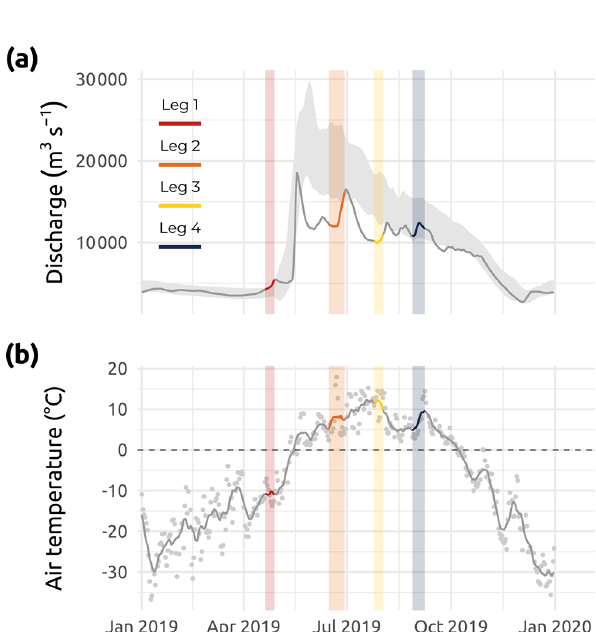
Figure 3. (a) Mackenzie River discharge (m 3 s − 1 ) from Jan- uary 2019 to January 2020 shown as the gray line with overlain colored segments corresponding to Legs 1, 2, 3, and 4 (data from ArcticGRO; Arctic Red River ID 10LC014; 67.45 ◦ N, 133.74 ◦ W; Shiklomanov et al., 2021; https://arcticgreatrivers.org/discharge/, last access: 3 February 2023). The gray shaded area in panel (a) represents mean values ( ± standard deviation) of the climatology from 2000–2022. (b) Air temperature ( ◦ C) from January 2019 to January 2020. The average (solid gray line) spread of air temper- ature data (gray points) and the 0 ◦ C threshold (dotted gray line) are presented. Colored segments correspond to Legs 1, 2, 3, and 4 sampling periods (data from Government of Canada, Environment and Climate Change Canada – Meteorological Service of Canada; measured at Tuktoyaktuk ID 2203914; 69.43 ◦ N, 133.02 ◦ W).